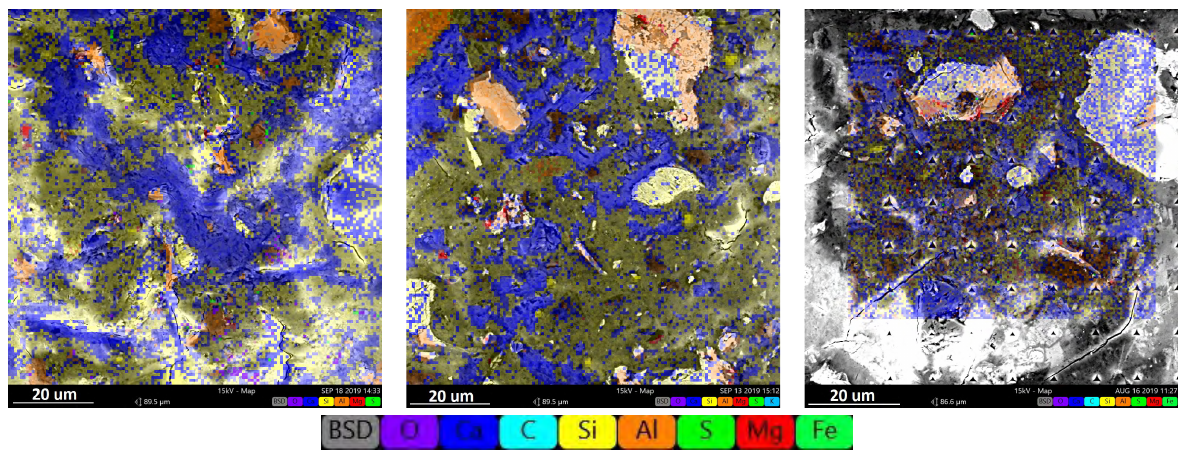
Figure 11. Maps of chemical elements from EDS analysis: a) C, b) CM and c)